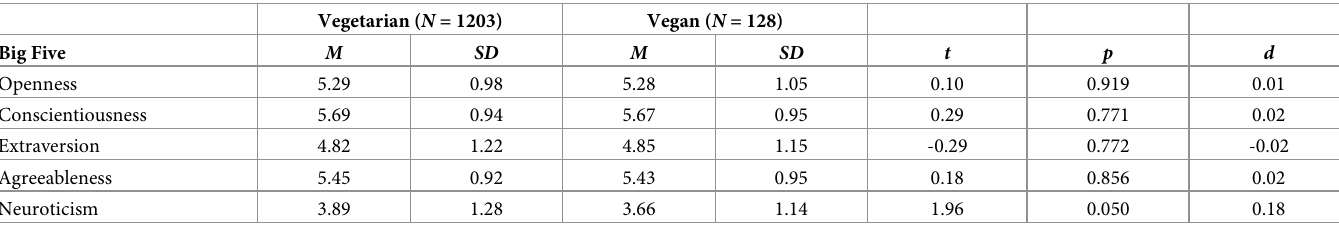
Table 2. Main study: Big five personality traits as a function of eating